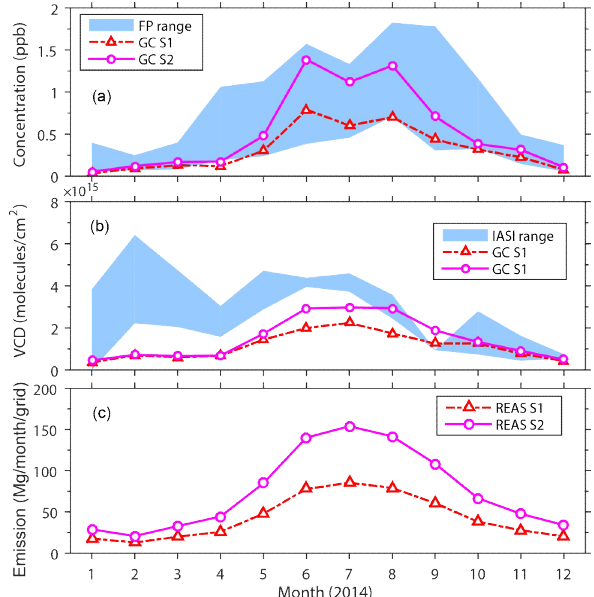
Figure 7. Time series of NH 3 in the Hokkaido region ( a ) FP and GEOS-Chem concentrations, ( b ) IASI